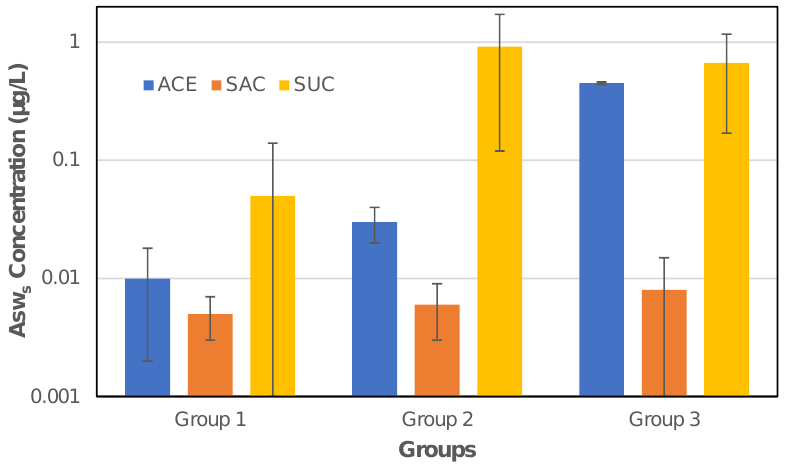
Figure 4. Concentrations of detected Asws (ACE, SAC, and SUC) in each of the three groundwater groups defined by the HCA.